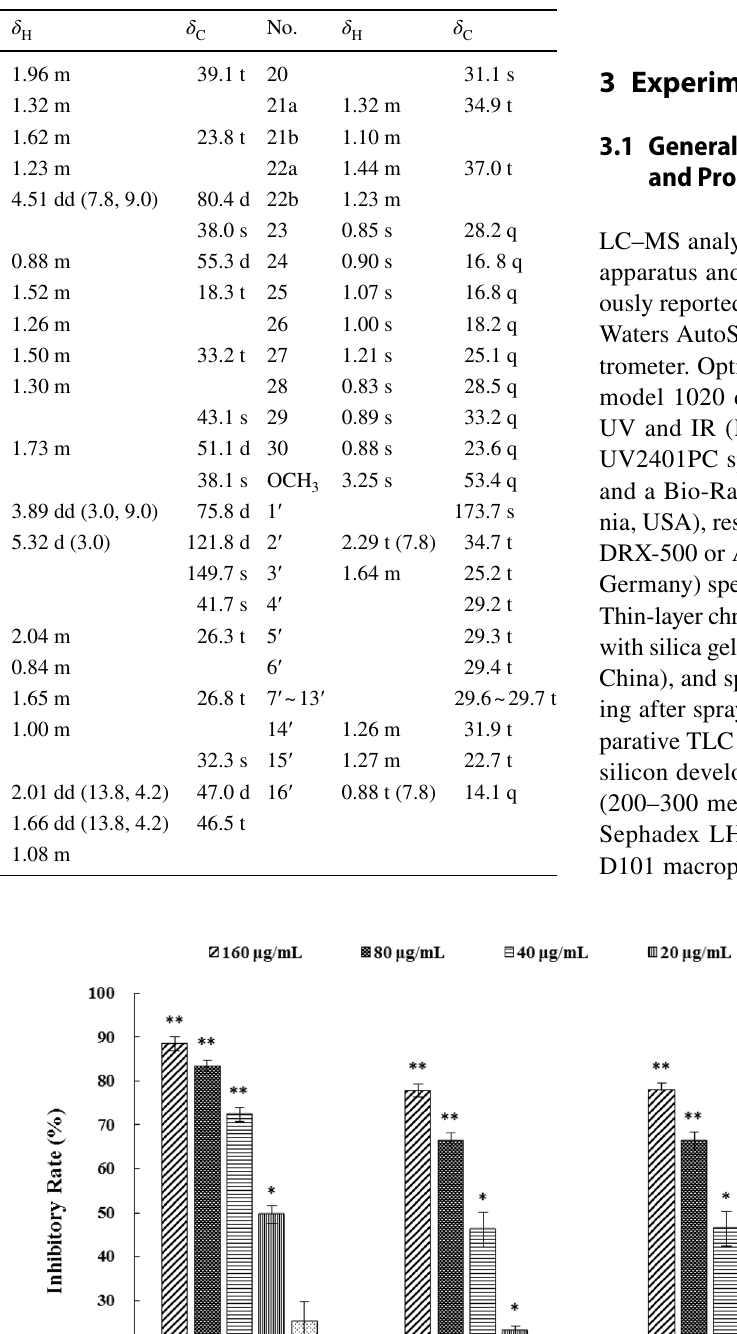
13 C NMR (150 MHz, 3 ) and